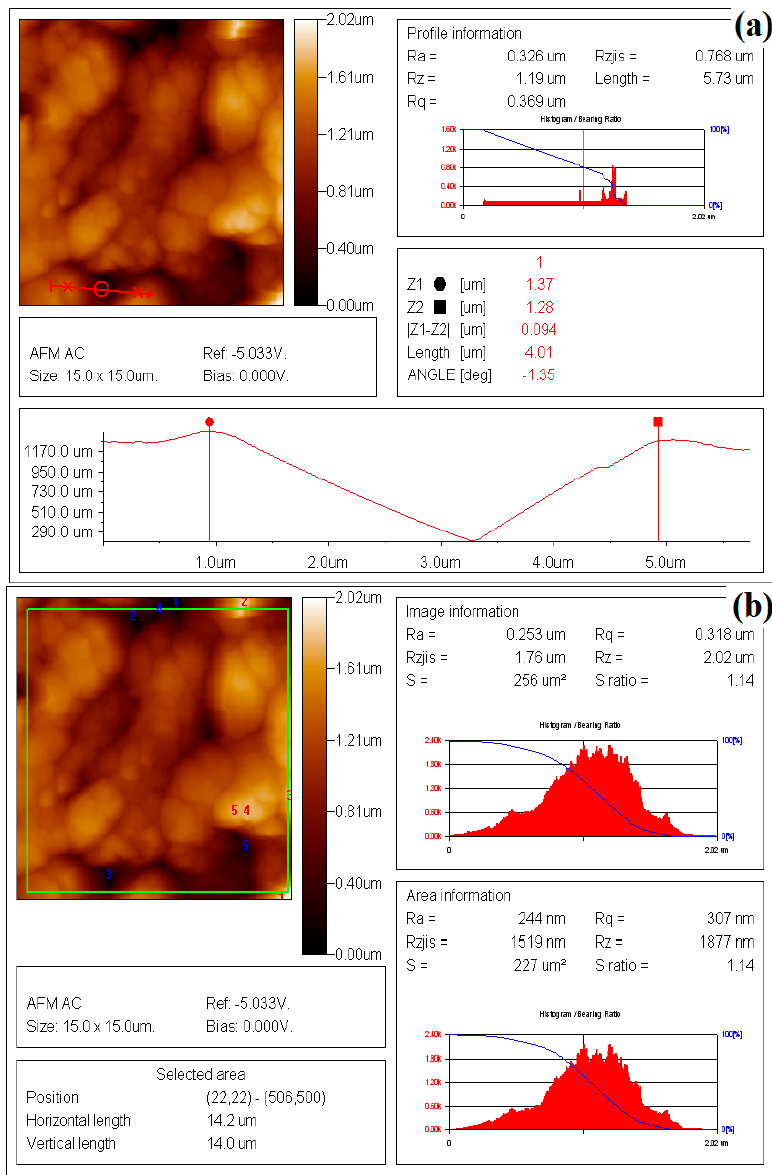
Figure 3. The sample images for the roughness of chitosan coating films analyzed by AFM: ( a ) AFM profile information of chitosan at 1.0%; and ( b ) AFM image information of chitosan at 1.0%. Table 1. The arithmetic average roughness ( Ra ) and the root mean square roughness ( Rq ) of chitosan coating films analyzed by AFM. CC: Chitosan Concentration; MPCF: Micropore profile in chitosan film; IICF: Image information of chitosan film; CCFT: chitosan coating film thickness; Mean data with different letters ( a – d ) differ significantly at p <